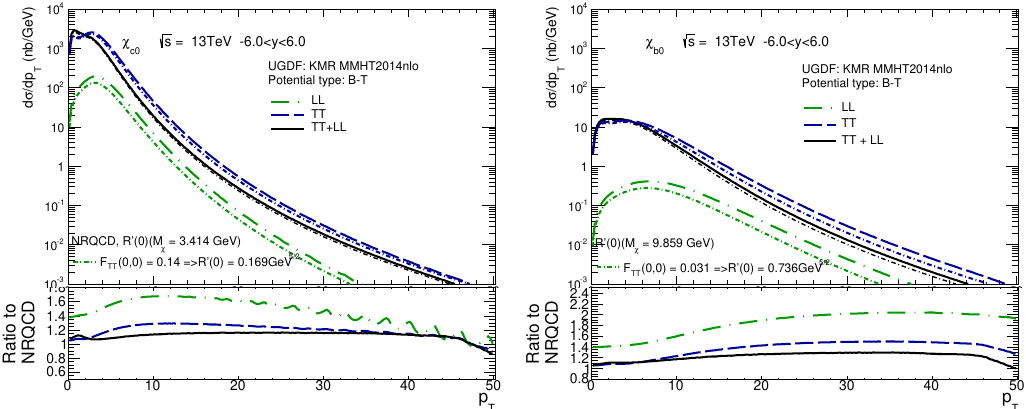
Figure 17 . The transverse momenta distributions of (cid:31) c 0 and (cid:31) b 0 with TT and LL components shown separately for the LF form factor as well as for the NRQCD form factor. The original masses from B-T potentials, m c = 1 : 48 GeV, m b = 4 : 87 GeV, are used to calculate the LF form factors. The derivative of radial wave functions at the origin were obtained from F TT (0 ; 0) (tables 2, 4) and R 0 (0) = 0 : 169 GeV 5 = 2 , R 0 (0) = 0 : 736 GeV 5 = 2 for (cid:31) c 0 , (cid:31) b 0 ,